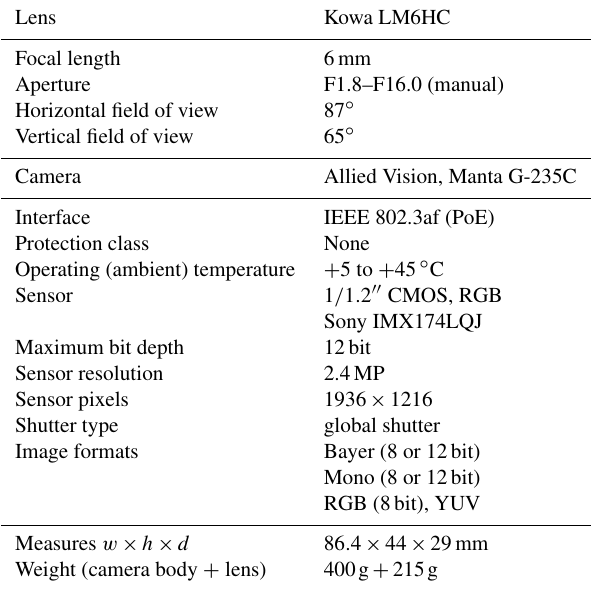
Table 1. HaloCam RAW